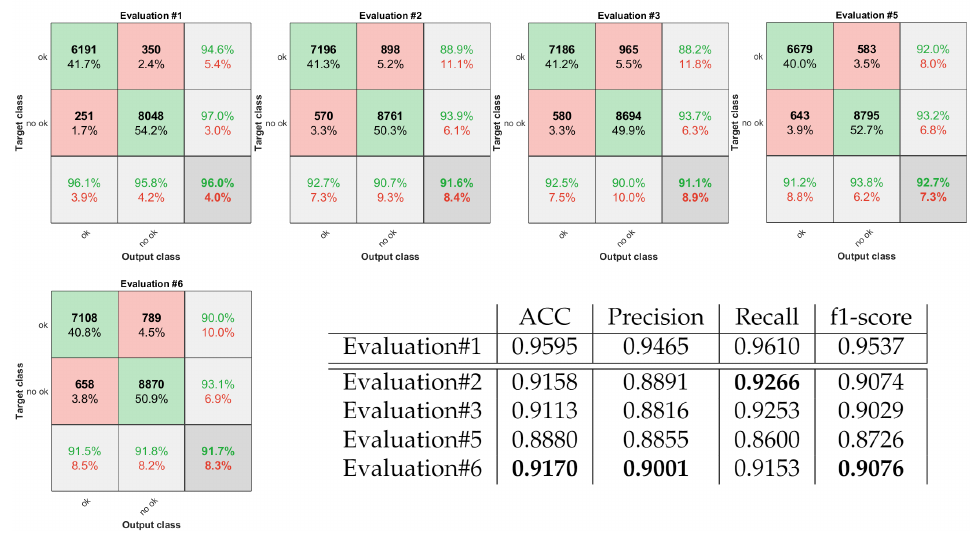
Figure 10. Confusion matrices and classification performance measures obtained for binary